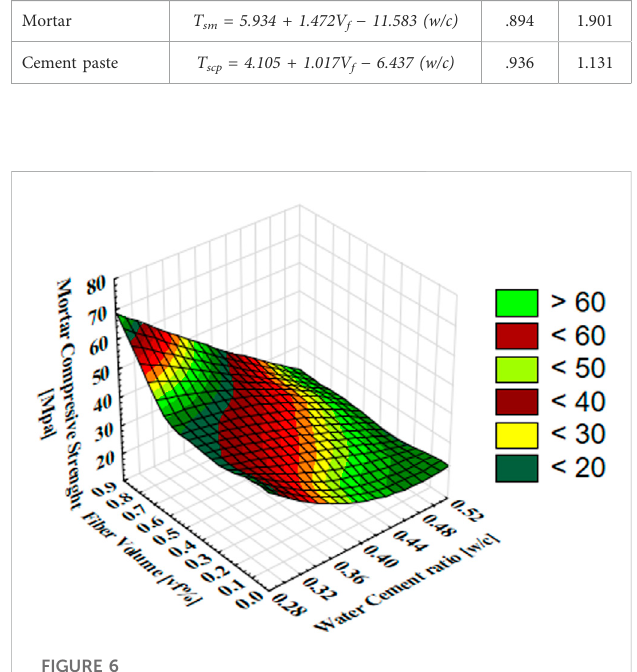
FIGURE 6 Mortar compressive strength (MPa) against fi bre V f and water- cement (w/c) ratio.